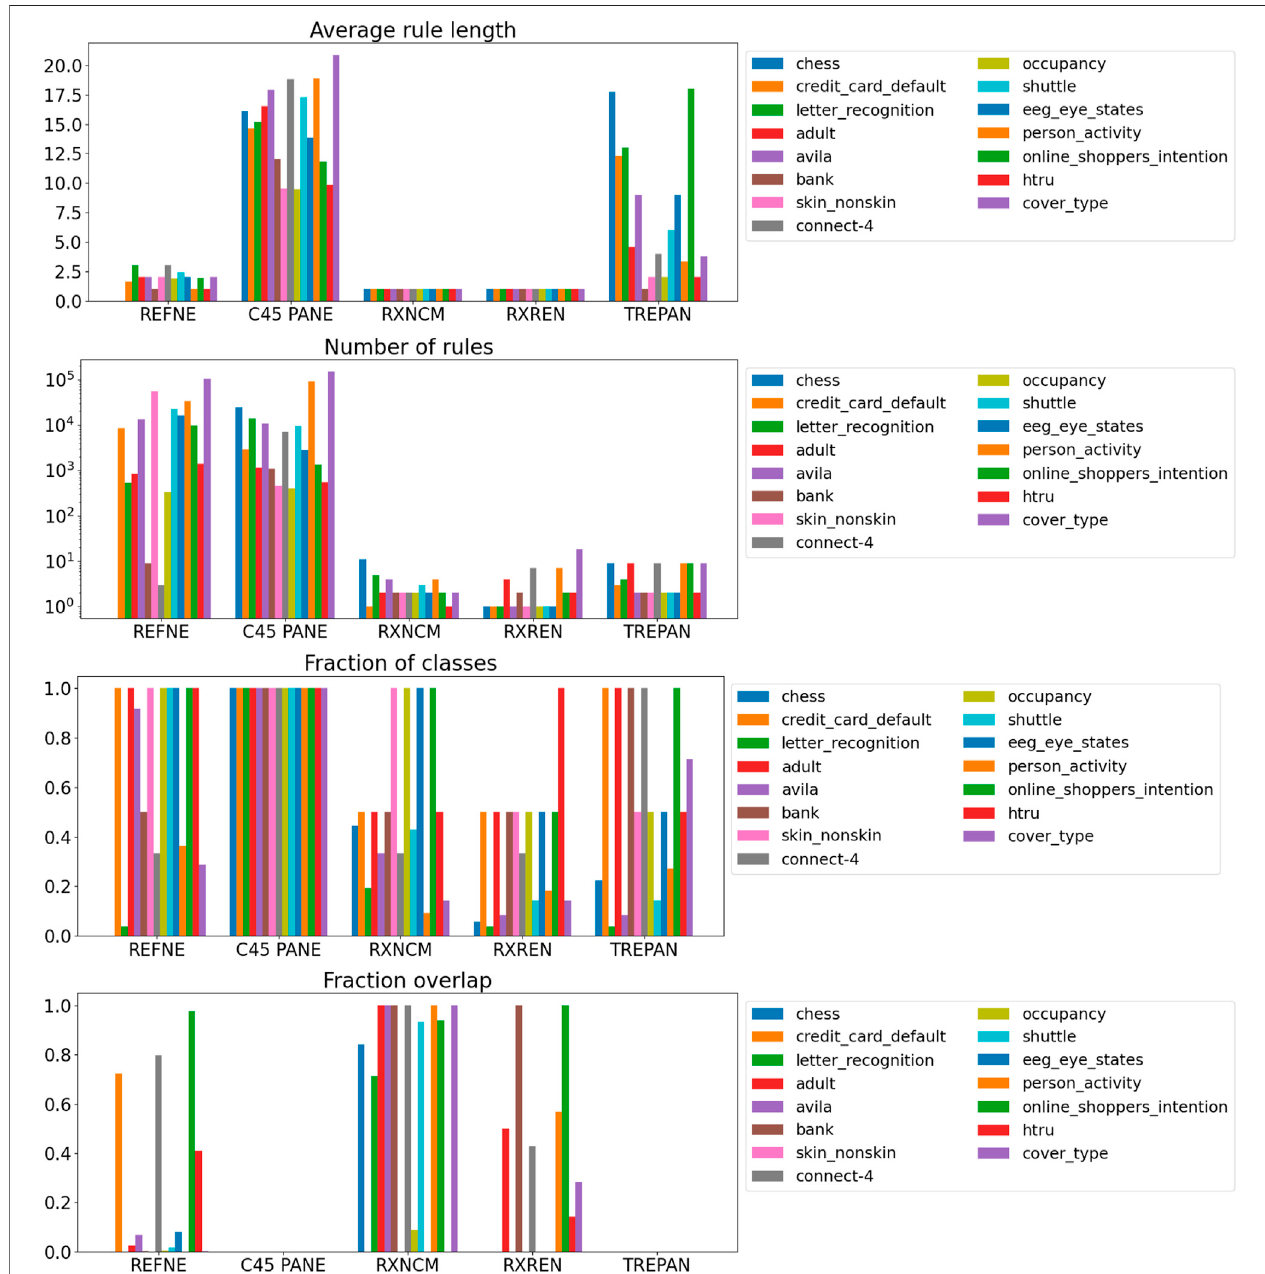
FIGURE4| Quantitativemeasuresofthedegreeofexplainabilityoftherulesetsautomaticallygeneratedby5rule-extractionmethodsover15datasets,groupedby method.